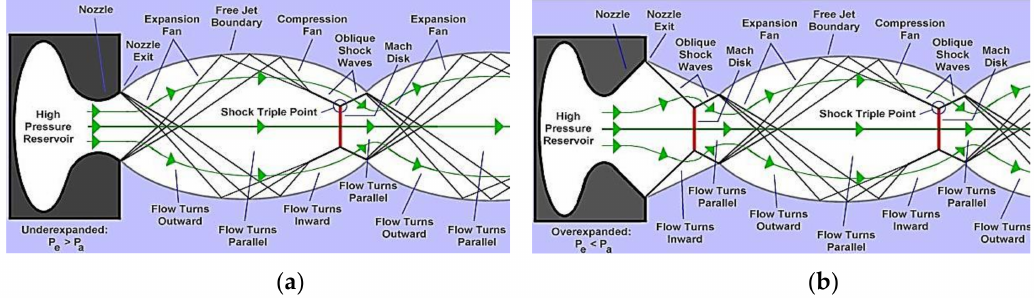
Figure 5. Shock diamond patterns of ( a ) under-expansion; ( b )